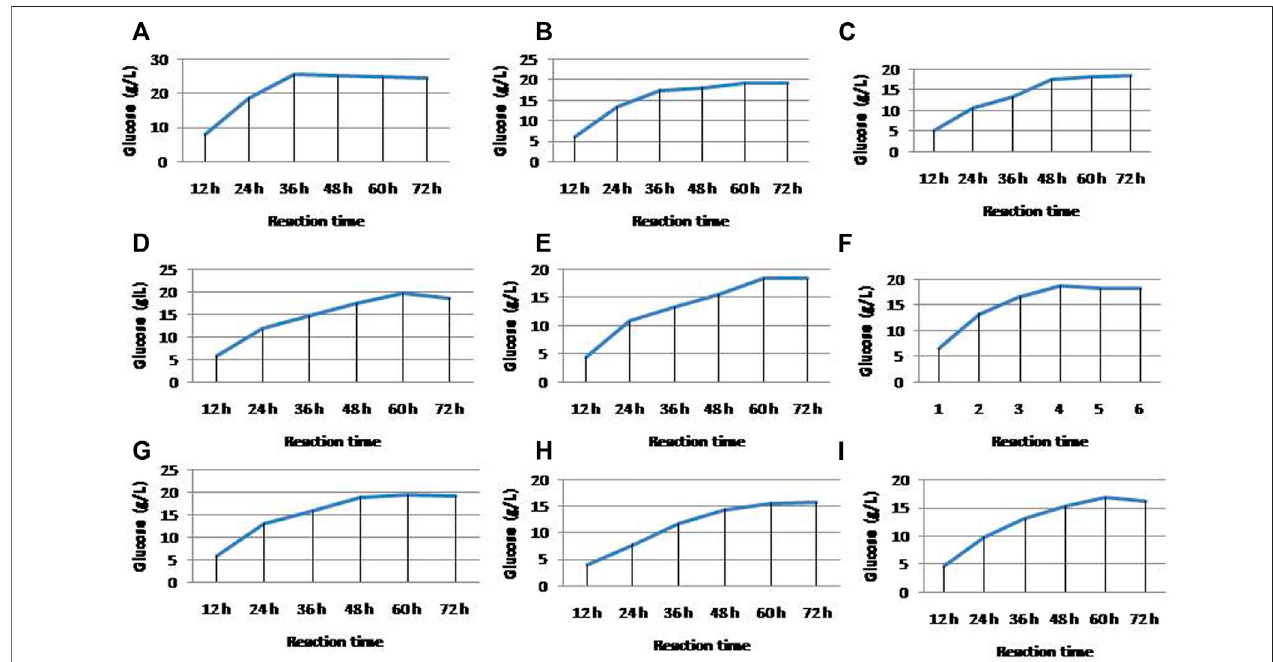
FIGURE 5 | Enzyme hydrolysis of nine different chemicals pretreated corn cob residue, (A) enzyme hydrolysis of NaOH-pretreated and acid-hydrolyzed residues, (B) enzyme hydrolysis of KOH-pretreated and acid-hydrolyzed residues, (C) enzyme hydrolysis of NaClO 2 -pretreated and acid-hydrolyzed residues, (D) enzyme hydrolysisofNa 2 SO 3 -pretreatedandacid-hydrolyzedresidues, (E) enzymehydrolysisofNH 3 -pretreatedandacid-hydrolyzedresidues, (F) enzymehydrolysisofHNO 3 - pretreated residues, (G) enzyme hydrolysis of H 2 SO 4 -pretreated residues, (H) enzyme hydrolysis of HCl-pretreated and acid-hydrolyzed residues, and (I) enzyme hydrolysis of H 3 PO 4 -pretreated and acid-hydrolyzed residues.